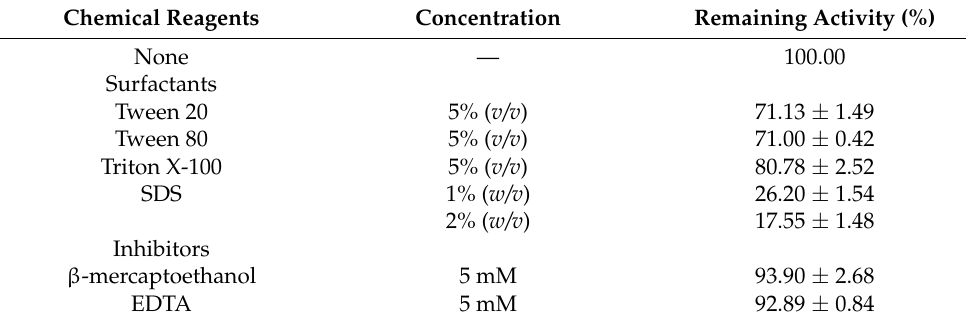
Table 3. Effects of surfactants and enzyme inhibitors on BCA